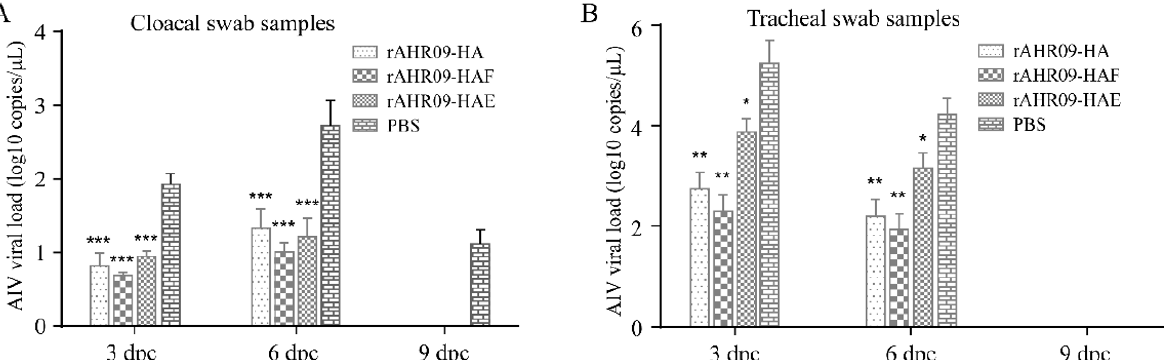
Figure 6. QRT-PCR quantitation of H9N2 AIV viral shedding in challenged chickens. The chickens were challenged with the 10 8 EID 50 H9N2 AIV YZ1406 strain at 21 days post-immunization. Cloacal swab samples ( A ) and tracheal swab samples ( B ) were collected 3, 6, 9 days post-challenge, and the levels of H9N2 AIV viral RNA were quantitated via QRT-PCR. Values are shown as mean values ± standard deviation (mean ± SD) in each group (* p < 0.05, ** p < 0.01, *** p < 0.001).